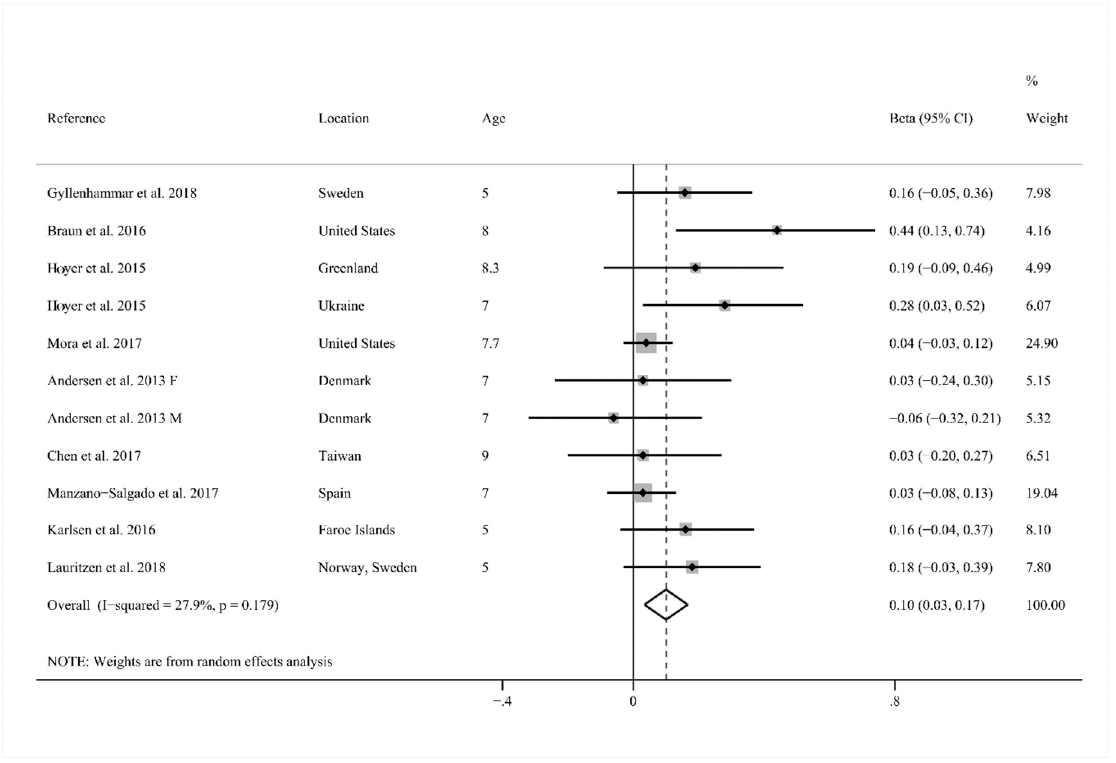
Figure 3. Forest plot of pooled β values for the association between exposure to perfluorooctanoic acid (PFOA) in early life and body mass index (BMI) z -score of childhood. CI: confidence interval; F: females; M: males.